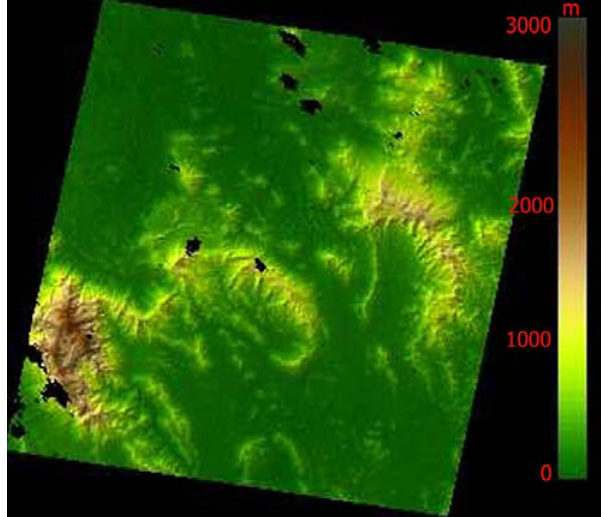
Figure 6. Digital Elevation Model (DEM) image map generated from ASTER Level 4A01 product for the study